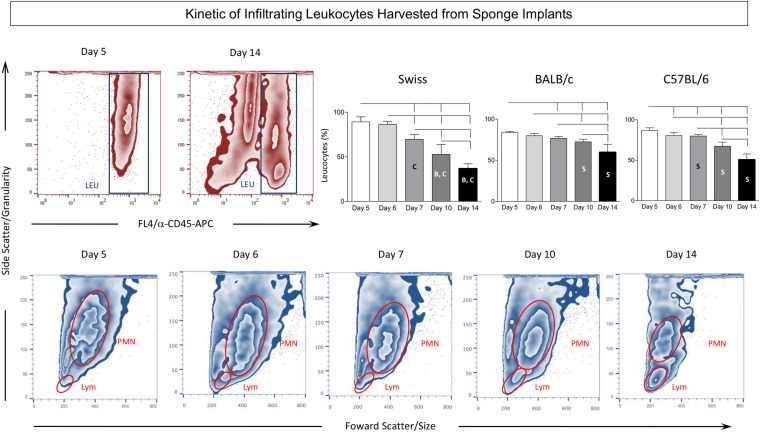
Kinetics of infiltrating leukocytes harvested from sponge implants. The sponge disks were subcutaneously implanted and removed at Day5, Day6, Day7, Day10, and Day14 post-implant. They were gently squeezed and cell suspension stained with anti-CD45 monoclonal antibody to selective flow cytometry quantification of leukocytes among the cells harvested from sponge implants. (Top panels) Representative zebra plots illustrate the decreasing predominance of leukocytes (LEU) among the cells harvested from sponge implants in Swiss mice. Statistical analysis further supports this finding and demonstrates that this phenomenon was more prominent in Swiss mice. Data are presented as mean ± standard deviation. Significant differences at p < 0.05 are underscored by connecting lines within the lineage and by letters “S”, “B”, and “C” for comparisons with Swiss, BALB/c, or C57BL/6, respectively. (Bottom panels) Follow-up analysis of flow cytometry morphometric features (Size – Forward Scatter/FSC and Granularity – Side Scatter/SSC) illustrated the progressive change in the leukocyte inflammatory infiltrate from general polymorphonuclear leukocytes (PMN) at Day5 toward a classical lymphocytic profile (LYM) at Day14.